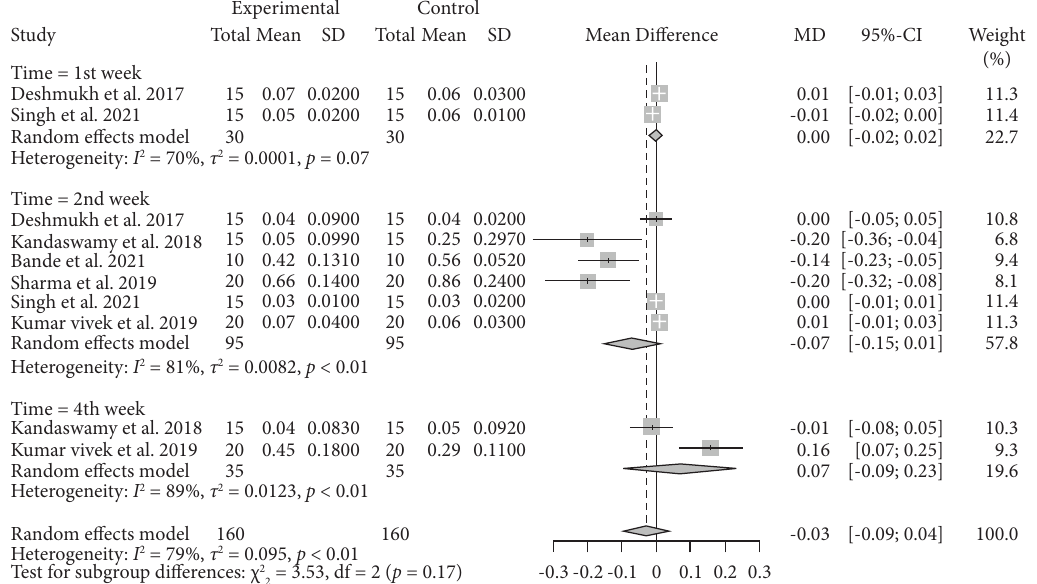
Figure 4: Forest plot for the gingival index (experimental: probiotics and control: